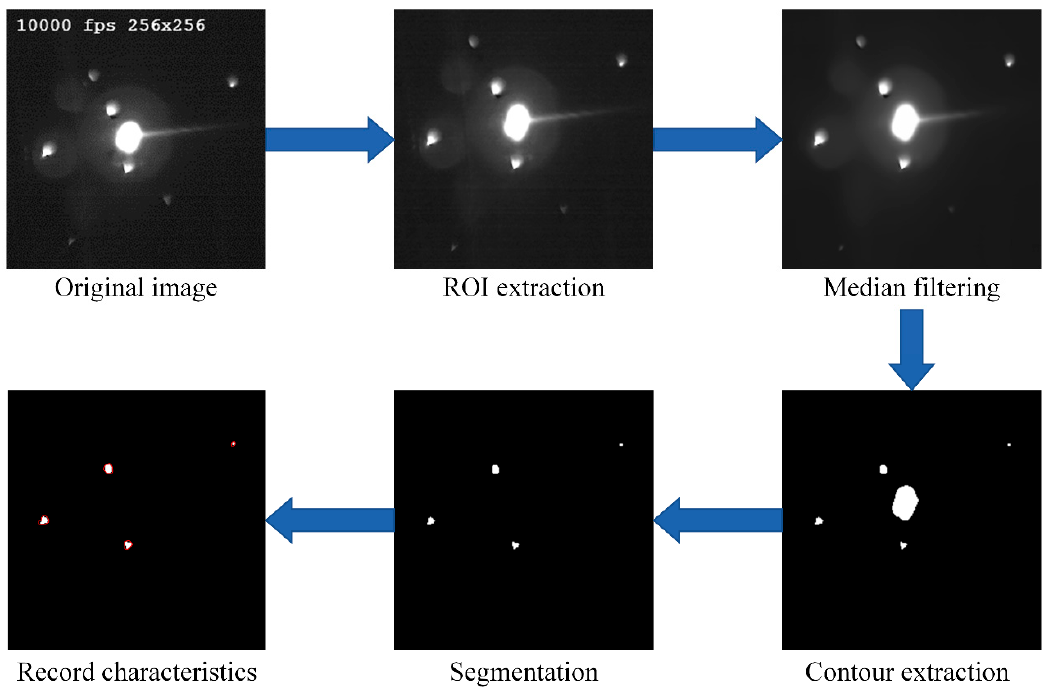
Figure 5. Steps of feature extraction for the spatter. (original image—ROI extraction—median filtering—record characteristics—segmentation—contour extraction).